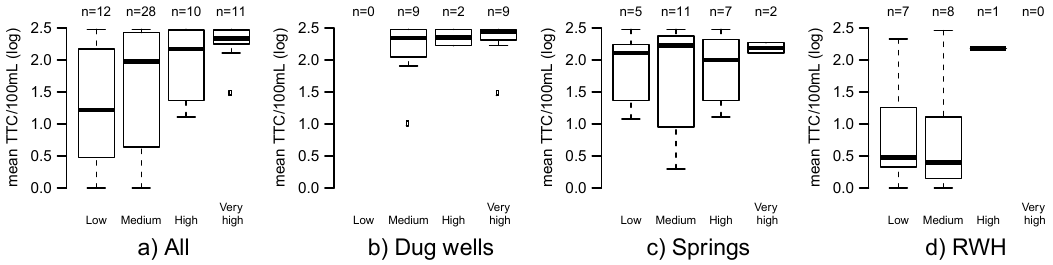
Figure 2. Boxplots of the thermotolerant coliform (TTC) concentrations for each RS category by: ( a ) All water sources; ( b ) Dug wells; ( c ) Springs; ( d ) Rainwater harvesting (RWH) systems.